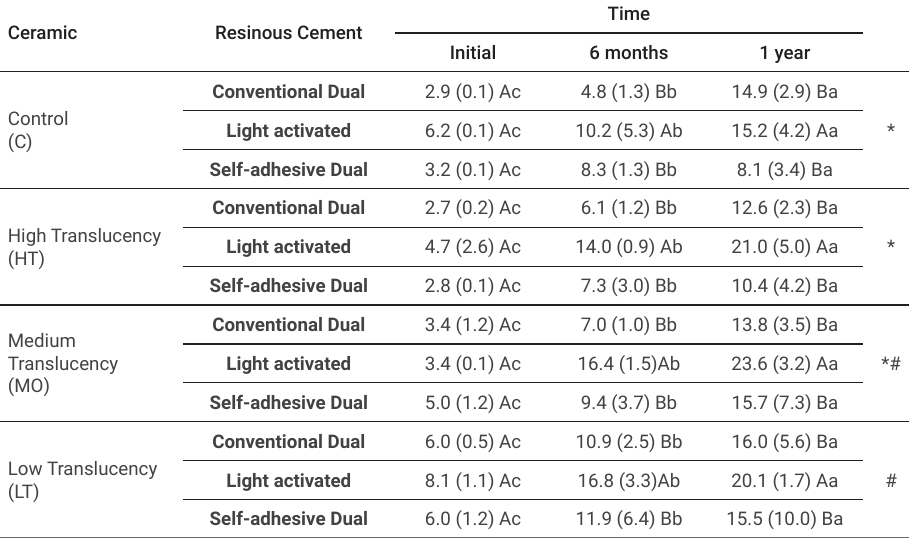
Table 3. Mean (standard deviation) of solubility data in experimental groups Ceramic Resinous